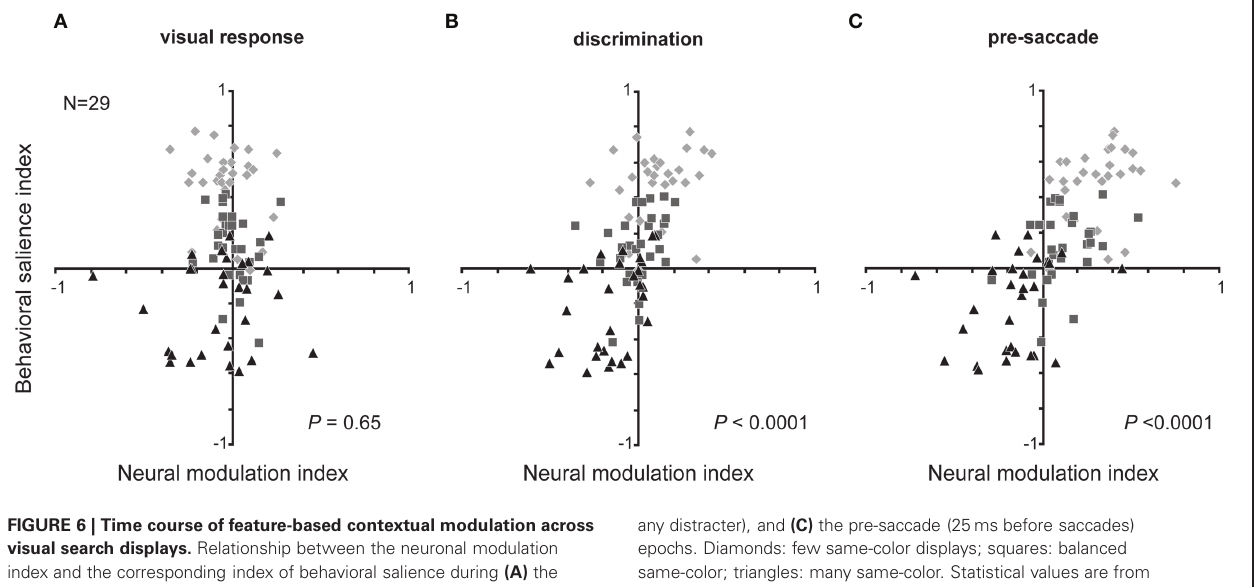
any distracter), and (C) the pre-saccade (25ms before saccades) epochs. Diamonds: few same-color displays; squares: balanced same-color; triangles: many same-color. Statistical values are from permutation tests (10,000 iterations) of the slopes of the linear